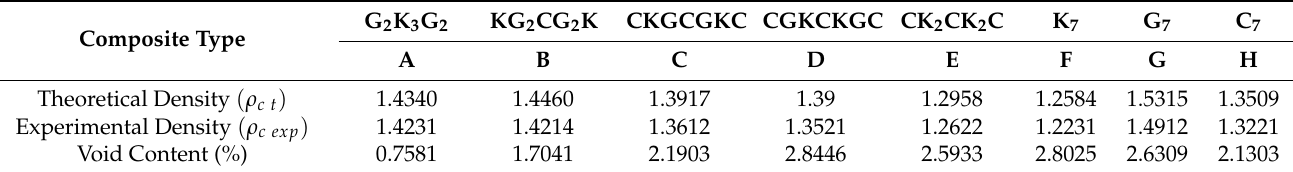
Table 1. Plain and hybrid composites name and their coded name, density, and void